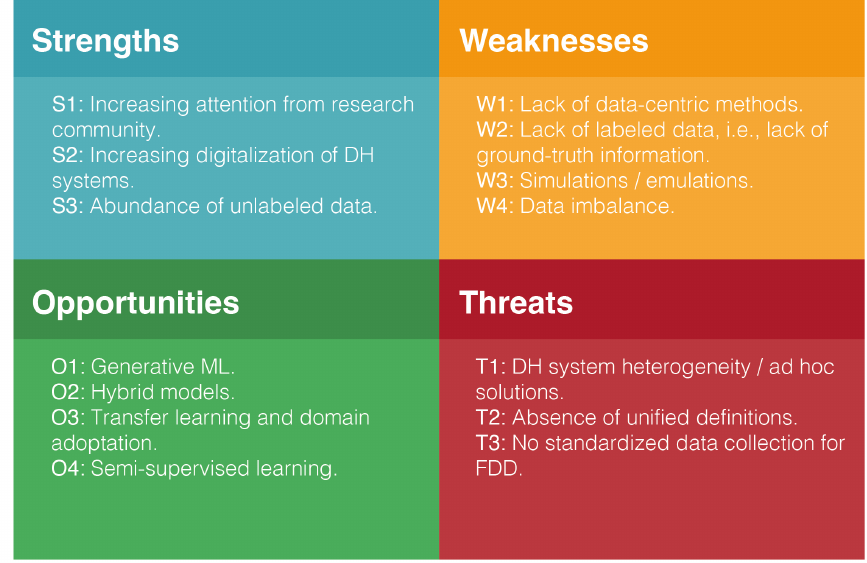
Figure 6. SWOT analysis from the perspective of intelligent FDD in